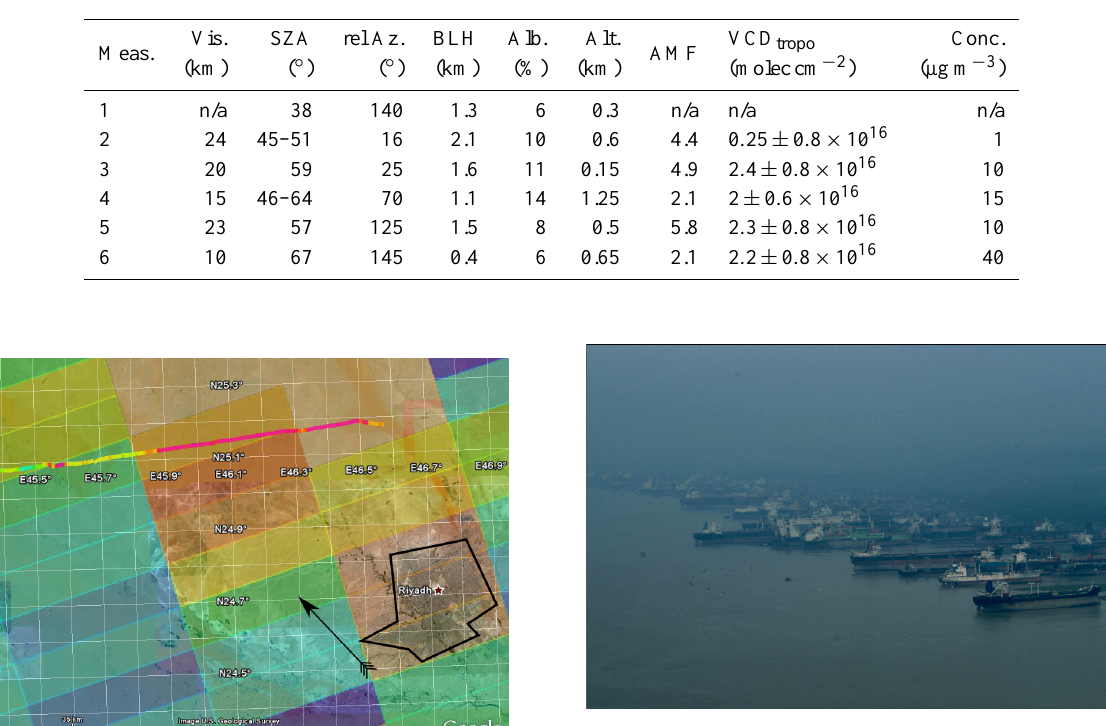
Fig. 13. Picture of Chittagong ship cemetery taken during the ex- pedition. The visibility is obviously low. Courtesy of Michel de